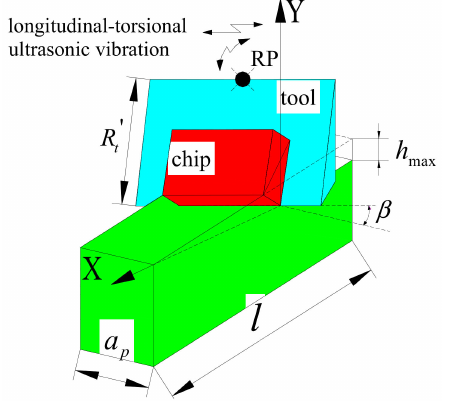
Figure 5. Model of oblique cutting.